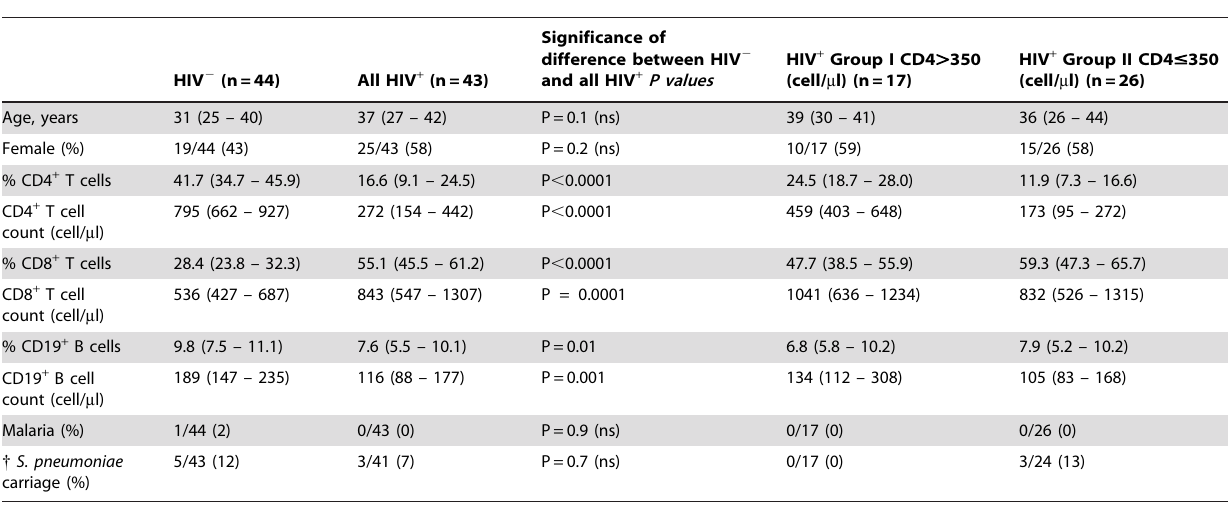
Table 1. Baseline demographic and immune parameters of HIV-infected and uninfected Malawian adult study participants.